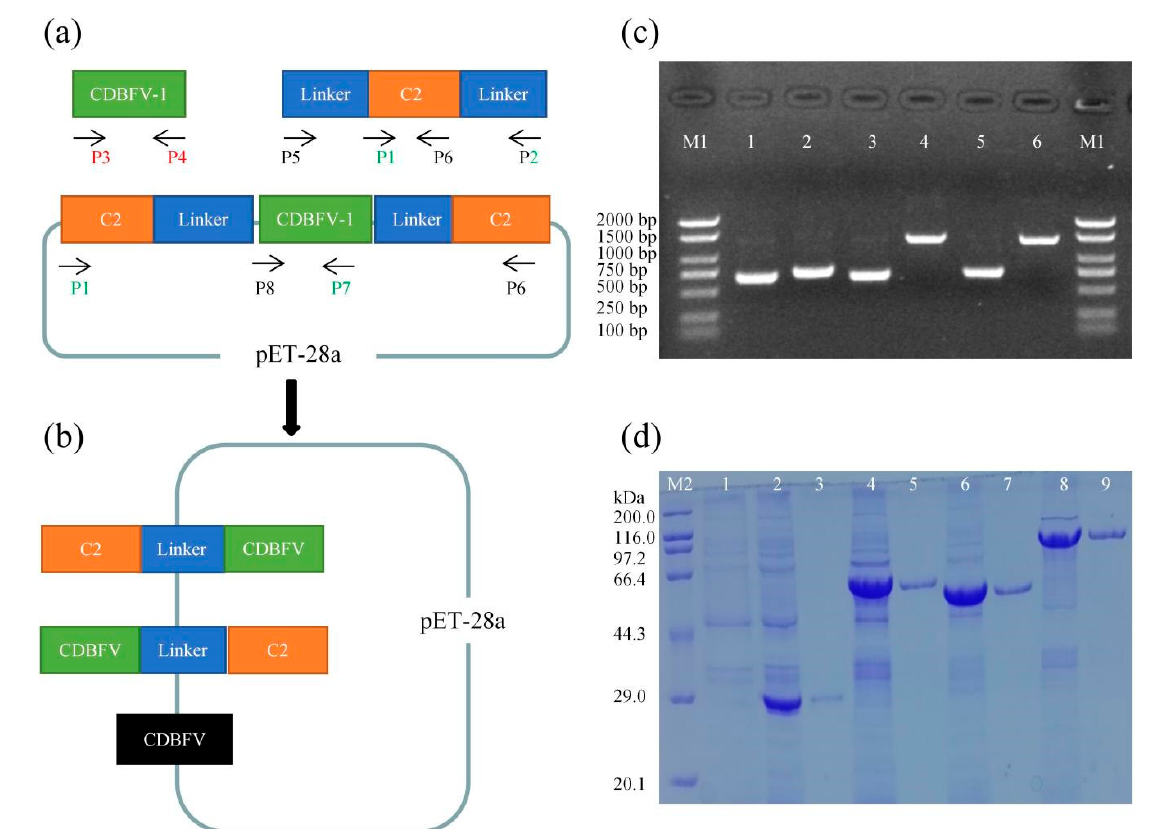
Figure 1. Construction of the chimeras. ( a ) Construction of the C2-CDBFV-C2 chimera model diagram. The C2L, CDBFV-1, and LC2 genes were amplified using P1/P2, P3/P4, and P5/P6, respectively. Orange represents the C2 gene; blue represents the linker gene; green represents the CDBFV gene; the arrow represents the direction of amplification. ( b ) Construction of the CDBFV, C2-CDBFV, and CDBFV-C2 model diagrams. The C2-CDBFV, CDBFV-C2, and CDBFV genes were amplified by using P1/P7, P6/P8, and P7/P8, respectively. ( c ) Agarose gel electrophoresis of amplified fragments. Lane M1: DNA molecular weight marker. Lane 1: gene of CDBFV-1. Lane 2: gene of C2L. Lane 3: gene of LC2. Lane 4: gene of CDBFV-C2. Lane 5: gene of CDBFV. Lane 6: gene of C2-CDBFV. ( d ) SDS–PAGE analysis of four xylanases. Lane M2: protein molecular mass marker. Lane 1: the strain with empty expression vector without the gene. Lane 2: CDBFV crude